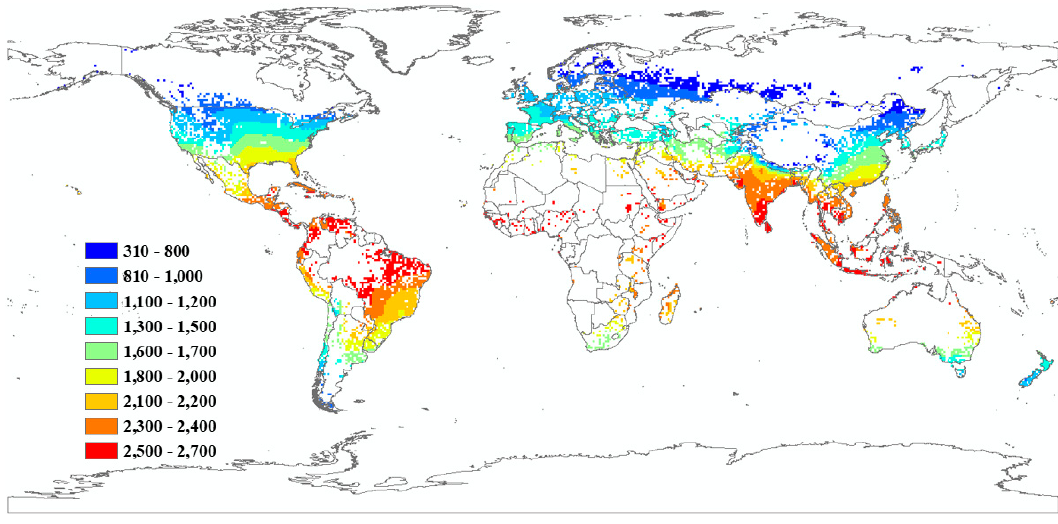
Figure 9. Net irrigation water requirement of MIROC5 model in 2050 (RCP4.5). The same irrigated